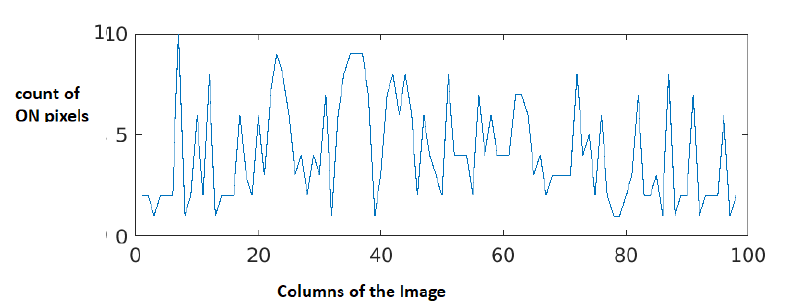
Figure 11. Histogram Projection-Line 1 (white spaces removed).